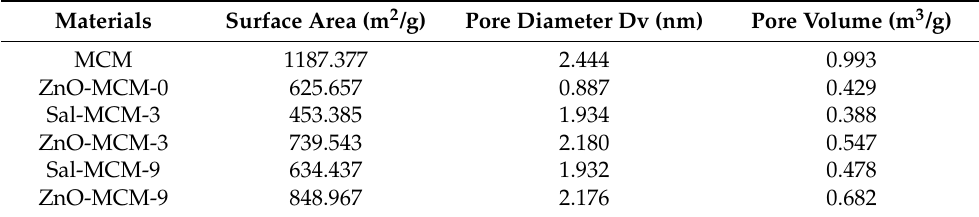
Table 1. The pore structural parameters of MCM-41, Sal-MCM, and